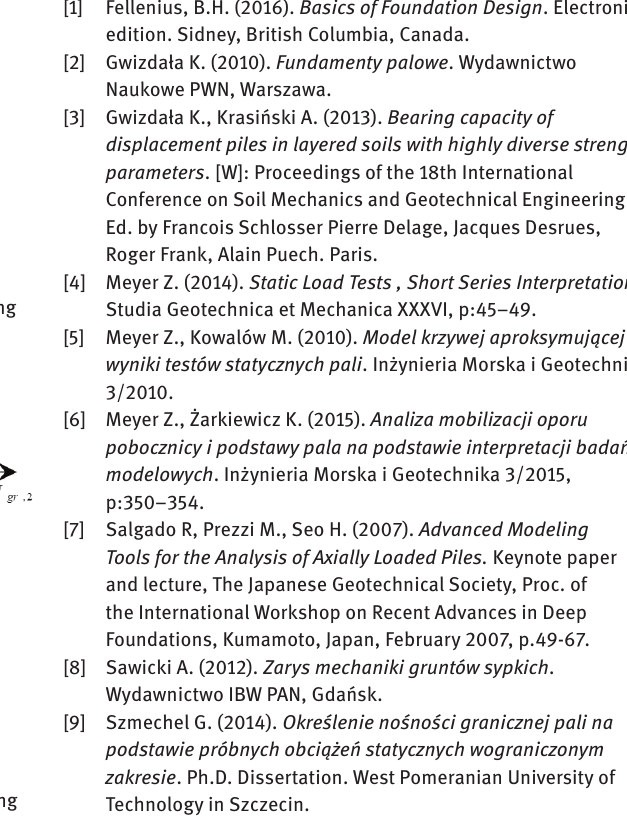
The figure of skin resistance mobilization indicated the maximum resistance reached at defined settlement.